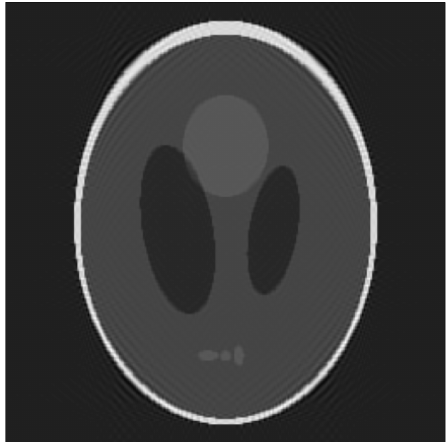
Figure 2. Ringing effect in a Shepp–Logan phantom. The effect has been magnified for visualiza- tion